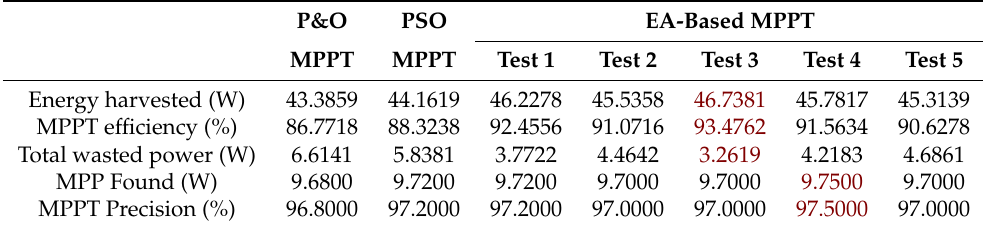
Table 6. Quantified experimental results for each MPPT